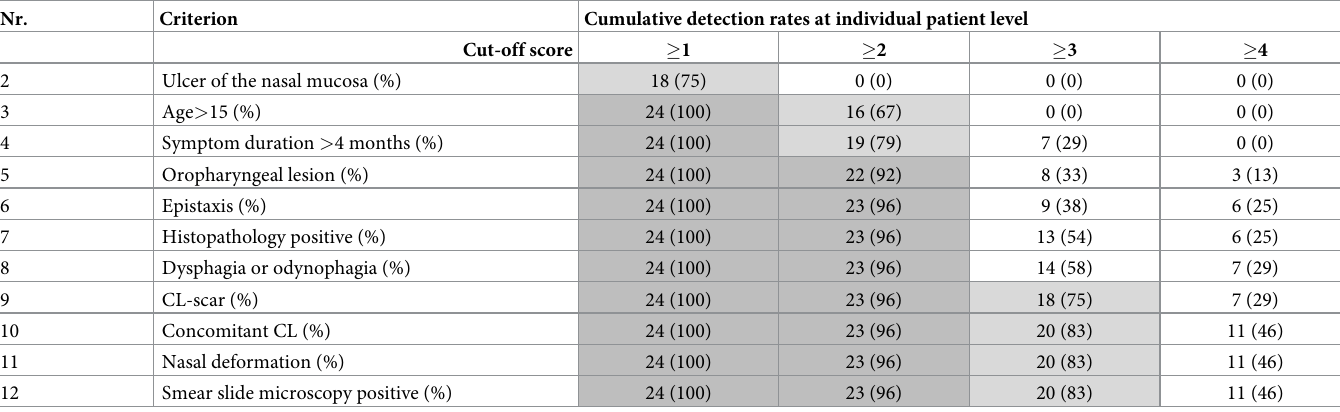
Table 6. Cumulative detection rates of clinical criteria in 24 female Mucosal Leishmaniasis (ML) patients.